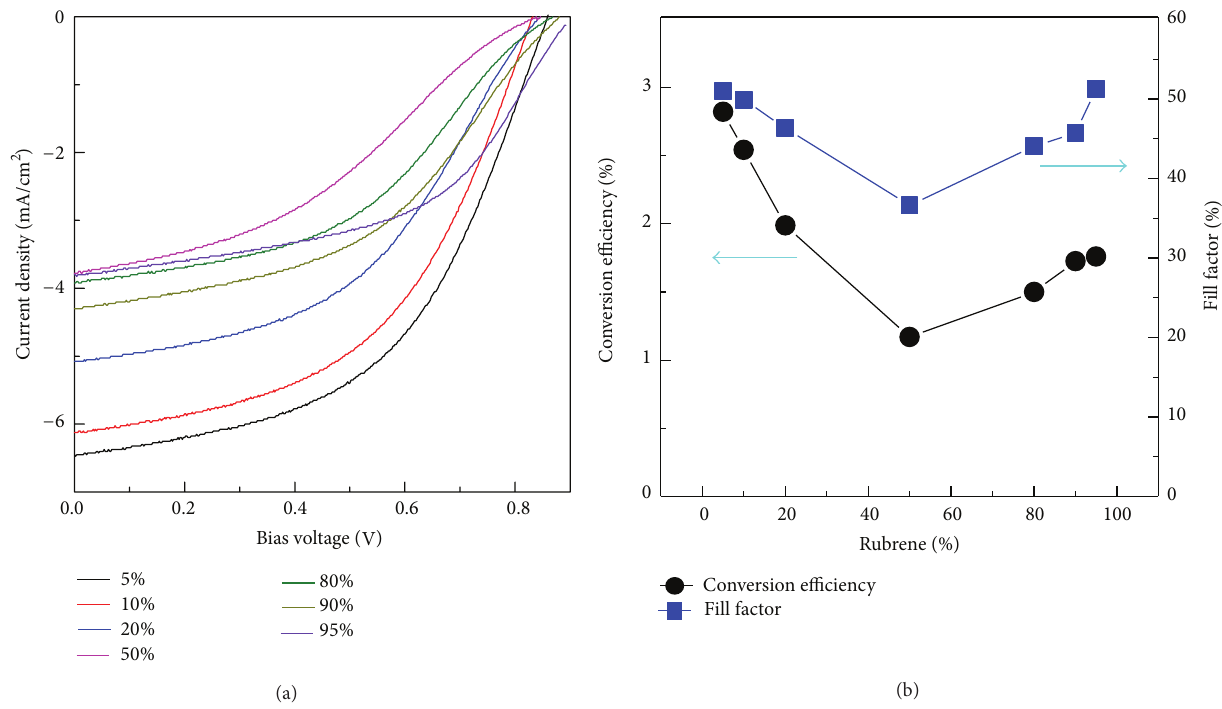
Figure 5: (a) Current density as a function of bias voltage for various rubrene ratios and (b) power-conversion efficiency and fill factor as a function of the rubrene ratio. Legends in (a) show the rubrene percent